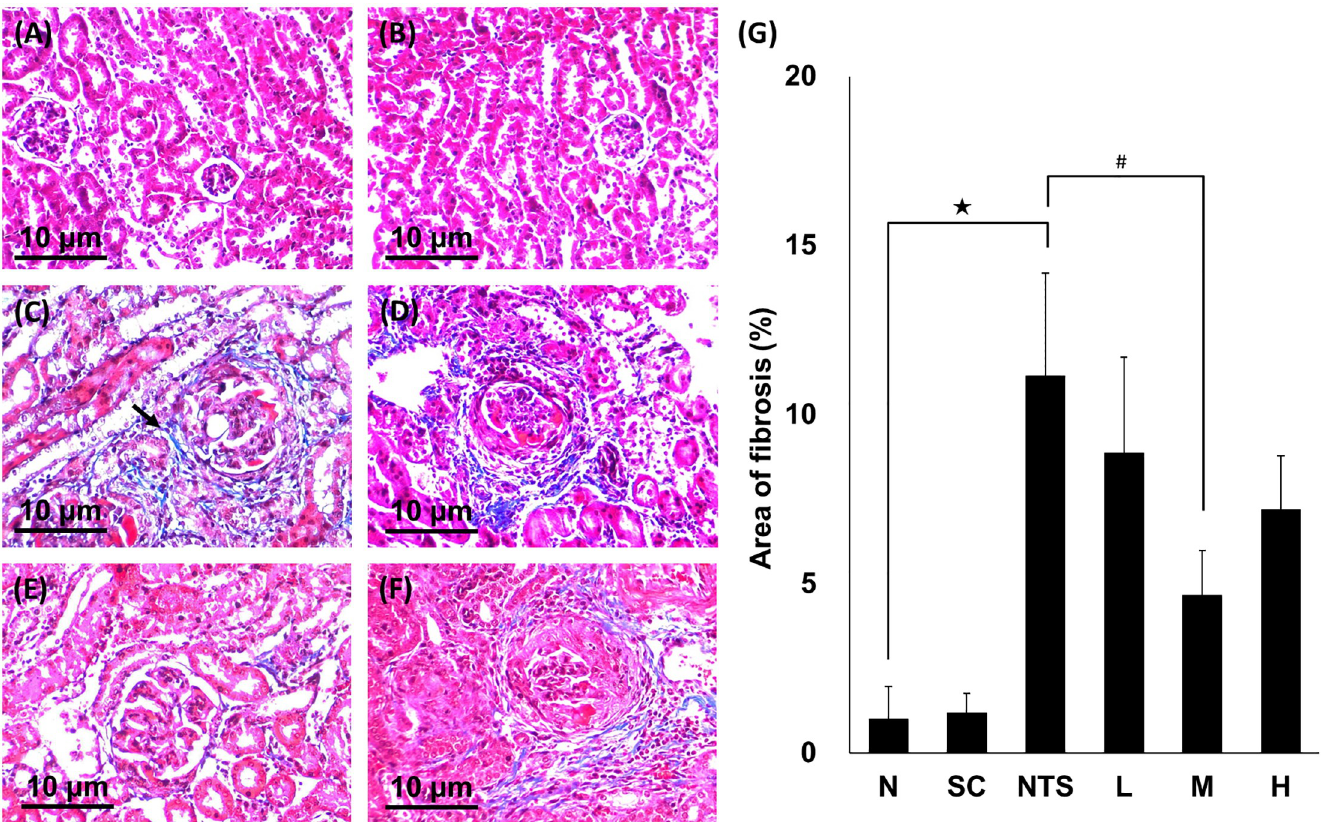
Fig 4. Masson’s trichrome-stained renal tissues from different experimental groups ( × 200 magnification). (A) Normal, (B) SSC control, (C) NTS control (arrow, the part of fibrosis), (D) NTS + SSC 5 mg/kg, (E) NTS + SSC 10 mg/kg, and (F) NTS + SSC 20 mg/kg. (G) Quantification of the area of fibrosis for each experimental group. $ p < 0.05 compared to normal group, # p < 0.05 compared to NTS control